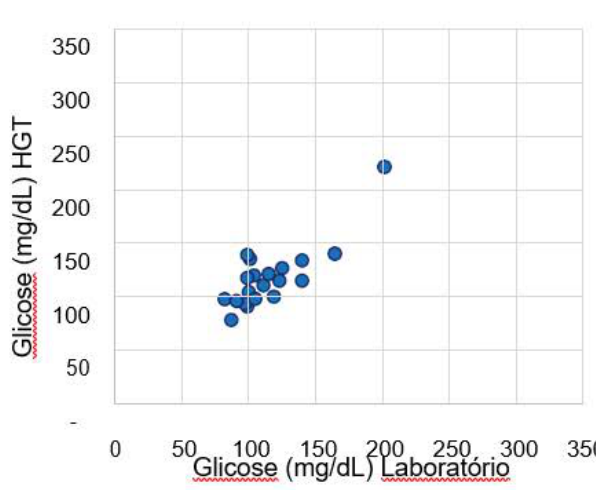
fIGuRE 2 – Graphical analysis of the linear correlation by rank between glucose measurements by glucometer (HGT) and conventional laboratory measurements